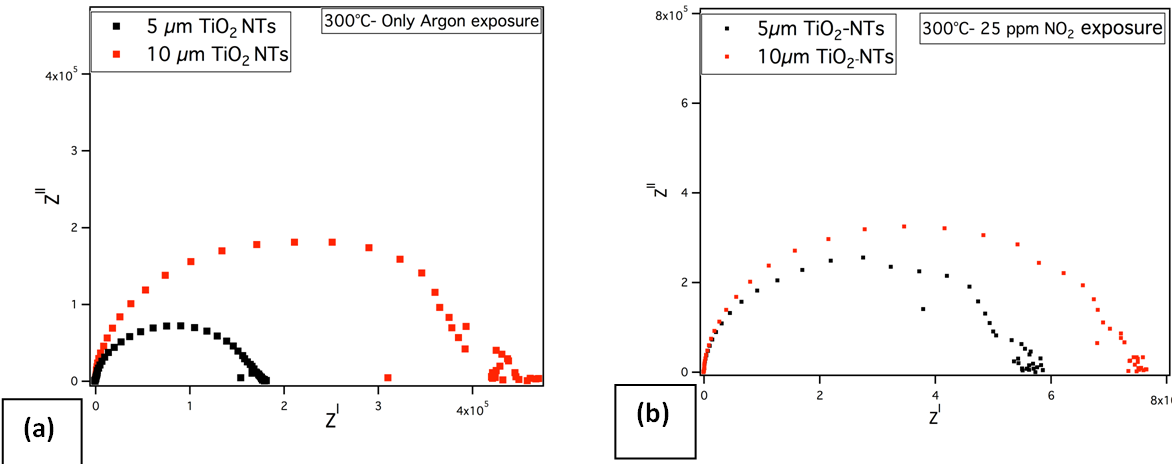
NTs indicating the 2